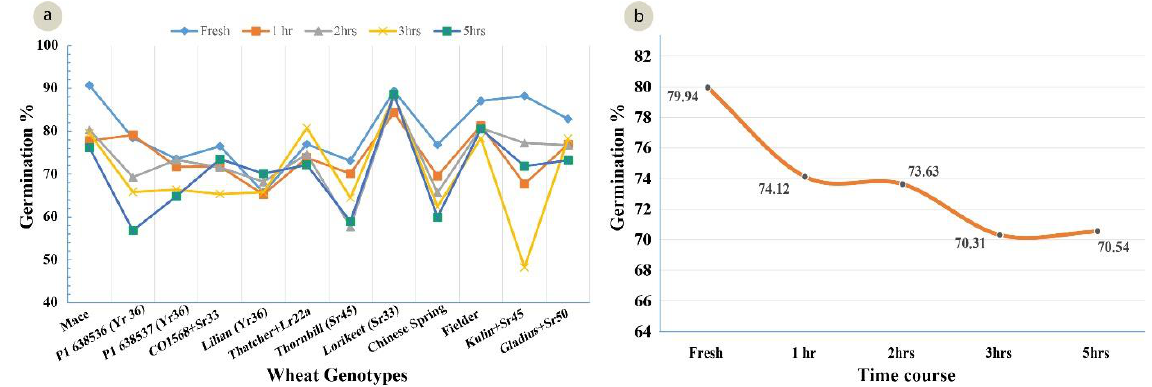
Figure 6. ( a ) Mean pollen viability of 12 wheat genotypes in their response to time course experiment (LSD 0.05 = 4.11); ( b ) Decline in pollen viability averaged over all 12 genotypes during the time period from 0 (fresh pollen) to 5 h after pollen harvest (LSD 0.05 = 6.36). The in vitro pollen germination data were compared with the IFC data for the geno- type PI 638537. The pollen viability values with IFC (74.44 ± 2.80) and in vitro (73.11 ± 8.62)